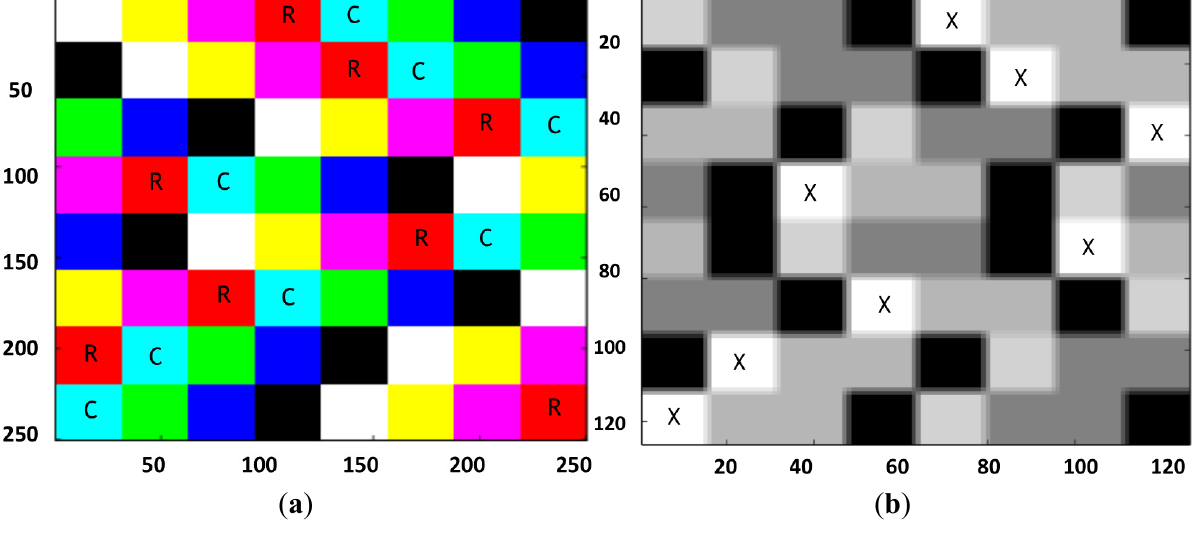
Figure 11. Outputs of the Cyan block before ( a ) and after ( b ) smoothing